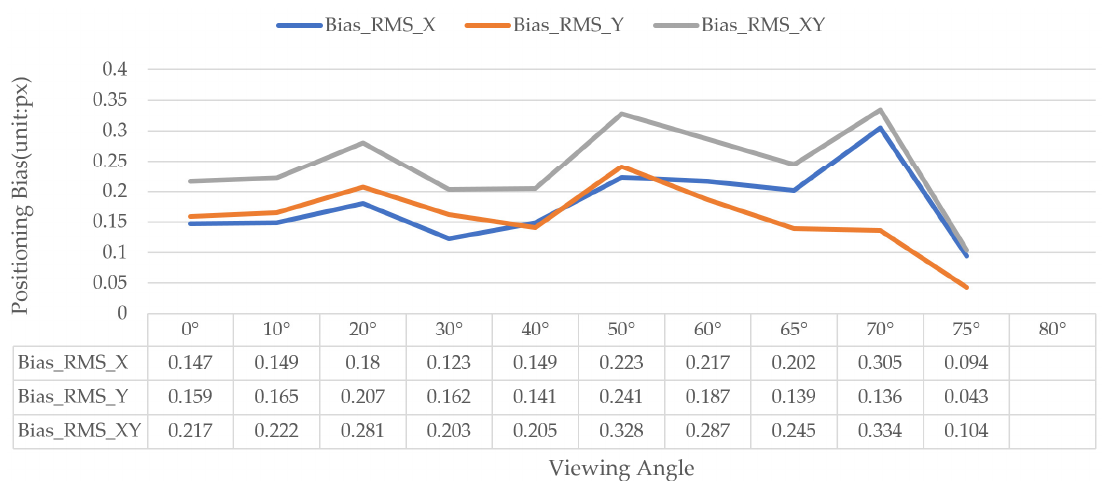
Figure 13. The center positioning precision under different viewing angles.